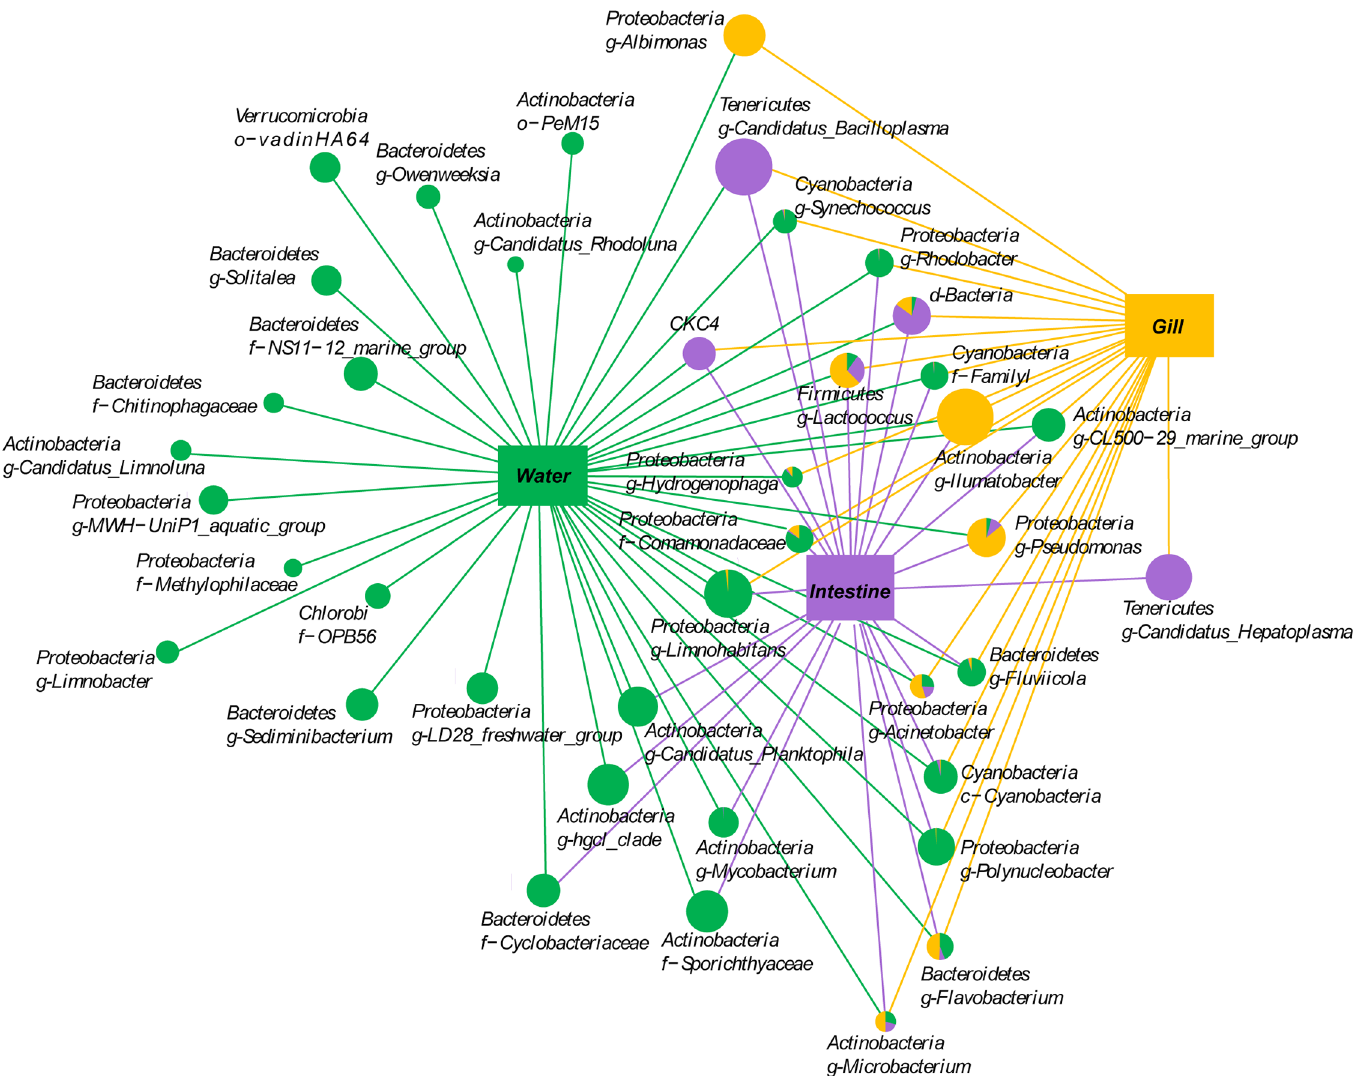
Fig 4. Network analysis visualizing the unique and shared bacterial groups in guts and gills of Chinese mitten crab and in the water in which they live. Node sizes correspond to the mean relative abundance of each bacterial group. The proportion of shared bacteria is represented by the different colors in the pie charts; if the proportion of the bacterial group is < 0.1% in gill, gut or water, these bacterial groups are shown with a line